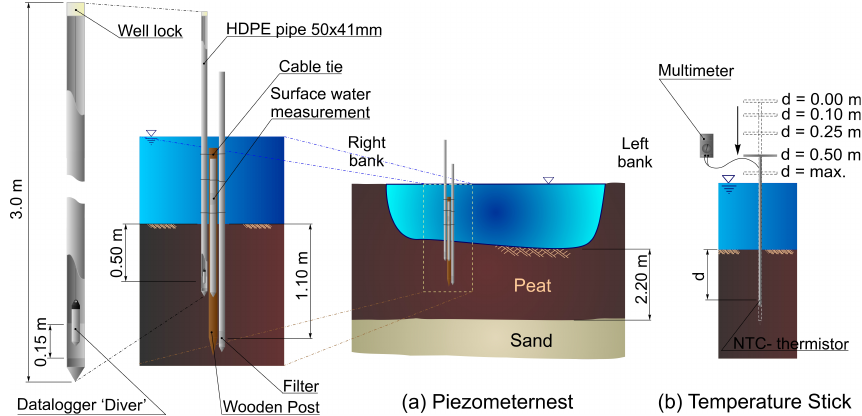
Fig. 4. (a) Setup for measuring temperature profiles and hydraulic head in the Biebrza River with piezometer nests equipped with data loggers, e.g. piezometer nest No. 2. (b) Scheme for measuring temperature profiles in the riverbed with the T-stick